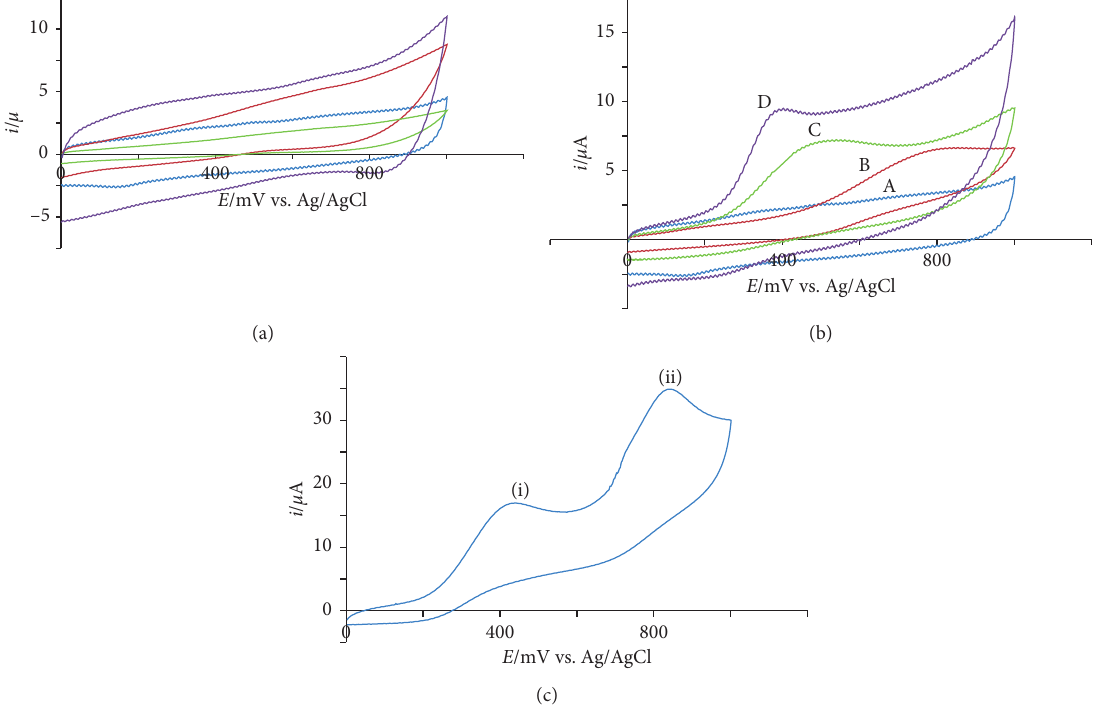
Figure 4: CVs in (a) 0.1 M PBS alone and (b) 1mM nevirapine in 0.1 M PBS (pH 11.0): (a) GCE, (b) TiO GNR/GCE. (c) Simultaneous analysis of nevirapine and glucose at TiO 2 /GNR/GCE, at a scan rate of 100mV/s.